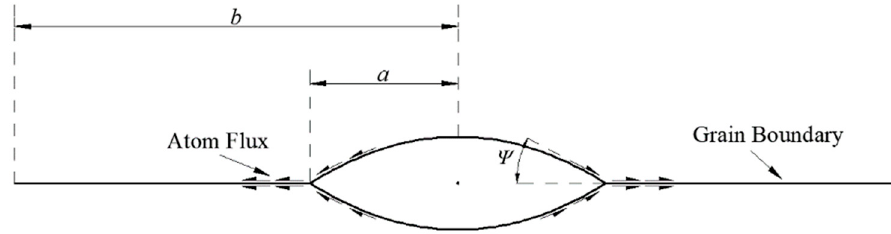
Figure 1. Idealized grain boundary cavity.